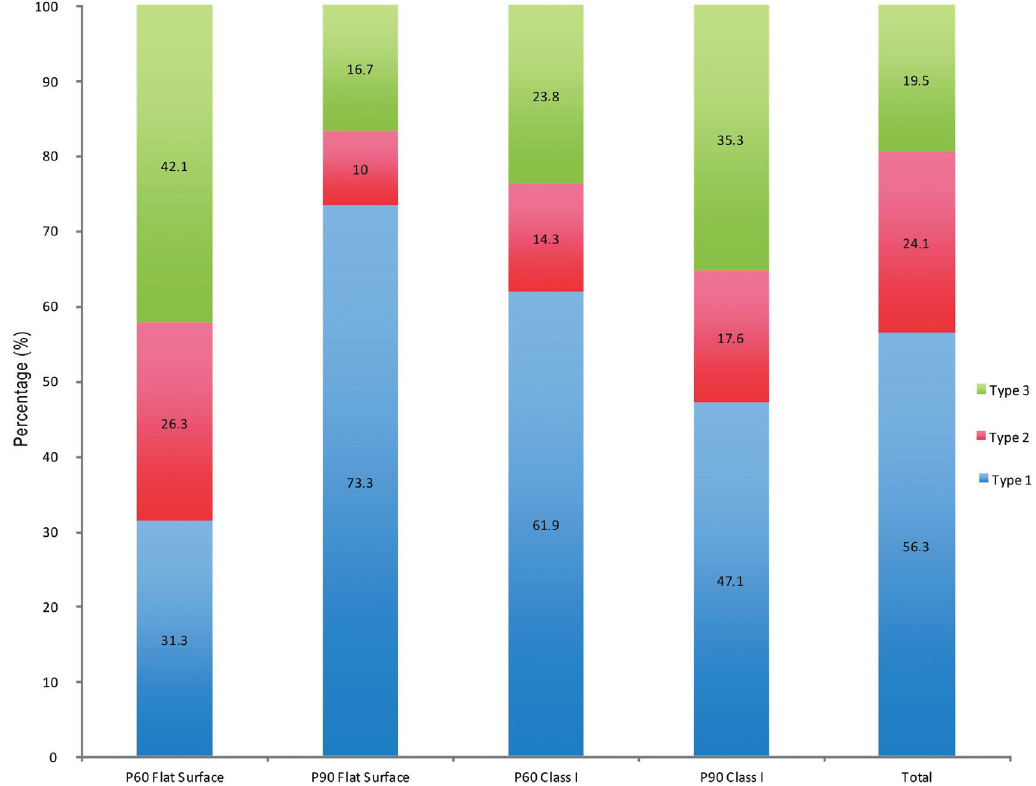
Means followed by different letters, (capitals in the horizontal and lower case in the vertical) differ among them (p<0.05)